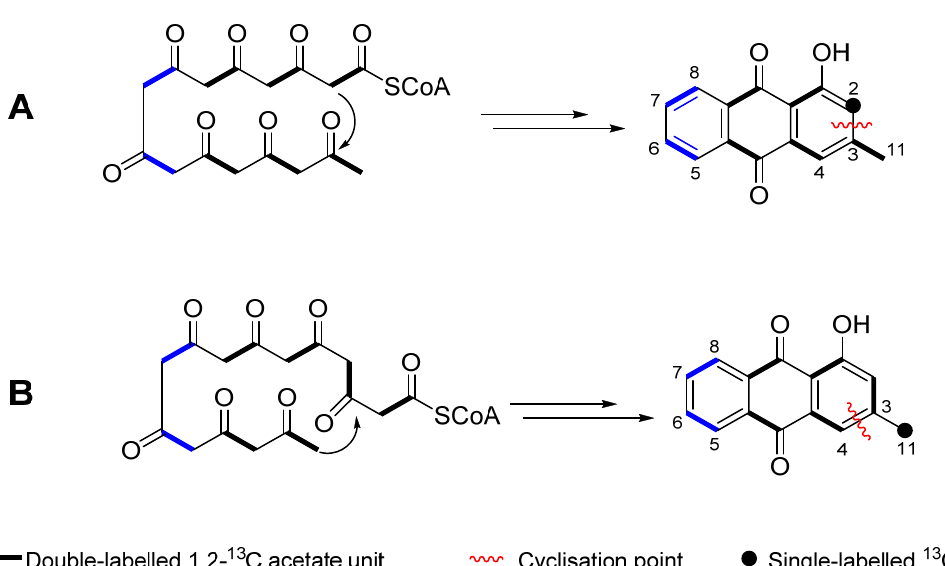
Figure 9. Predicted F ′ -mode ( A ) and F ′ -mode ( B ) octaketide folding for pachybasin ( 5 ).